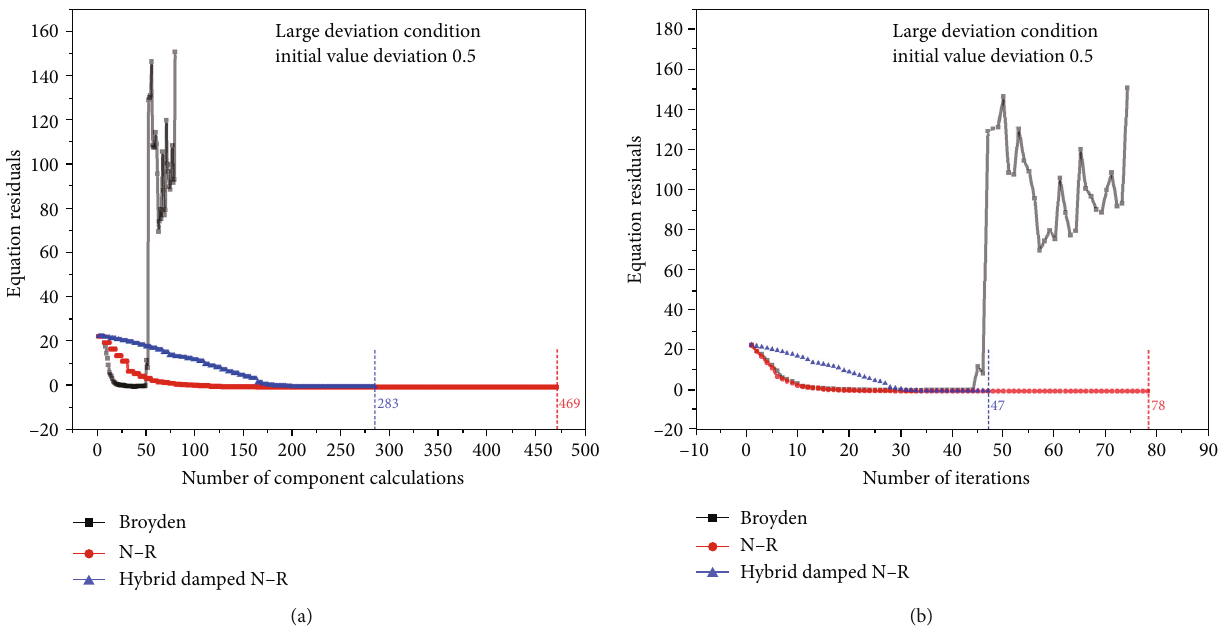
Figure 5: The variation of residuals with the number of model calculations and iteration steps under the initial deviation of